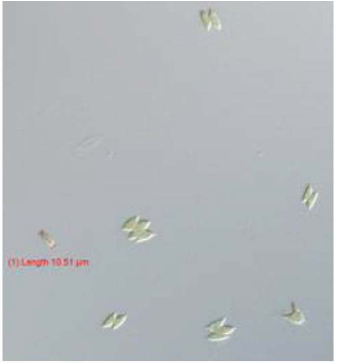
Fig. 6a. Morphological observation of Acutodesmus obliquus CN01 with 40X magnification.